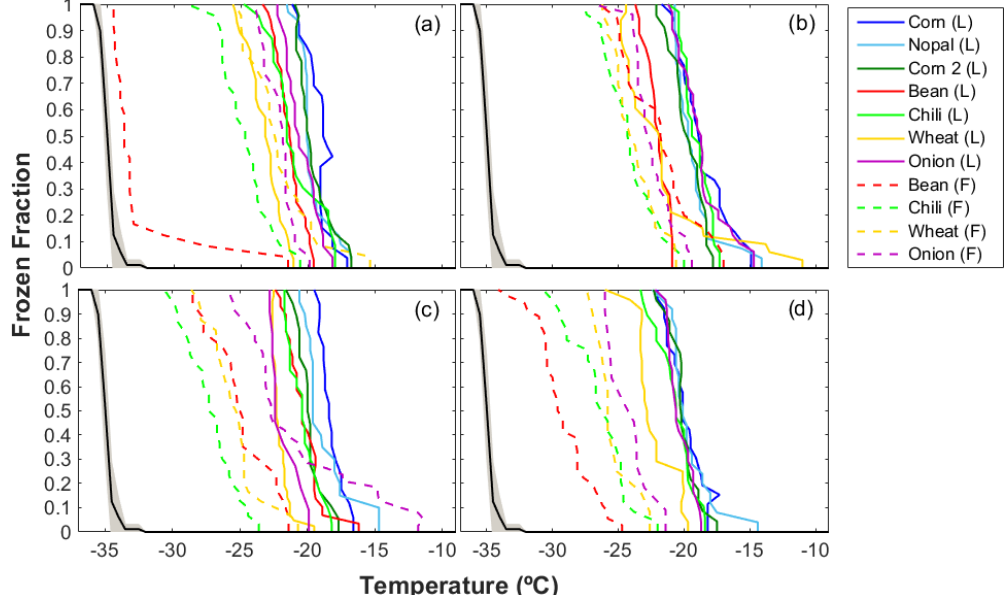
Figure 3. Ice nucleating abilities of the agricultural soil particles as a function of temperature for particle aerodynamic diameters of (a) 3.2– 5.6µm, (b) 1.8–3.2µm, (c) 1.0–1.8µm, and (d) 0.56–1.0µm. The black line depicts the average homogeneous freezing curve. The dashed and solid lines show the results for the samples collected in the field (F) and the samples generated in the laboratory (L), respectively.